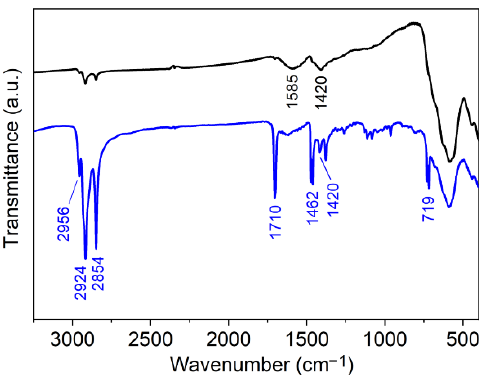
Figure A1. FTIR spectra before (blue) and after (black) washing and size selection.